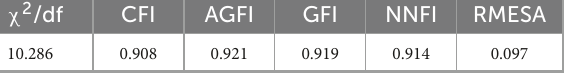
TABLE 5 Model fit index of the mediating role of perceived social support and autonomous fitness behavior. χ 2 /df CFI AGFI GFI NNFI RMESA